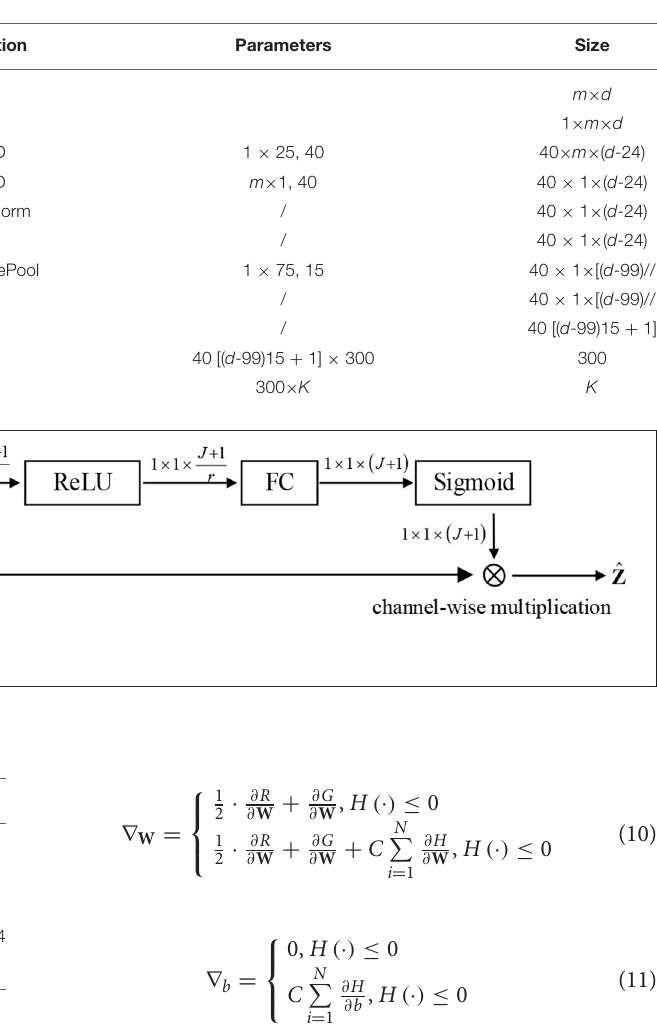
TABLE 1 | Network architecture of AConvNet.